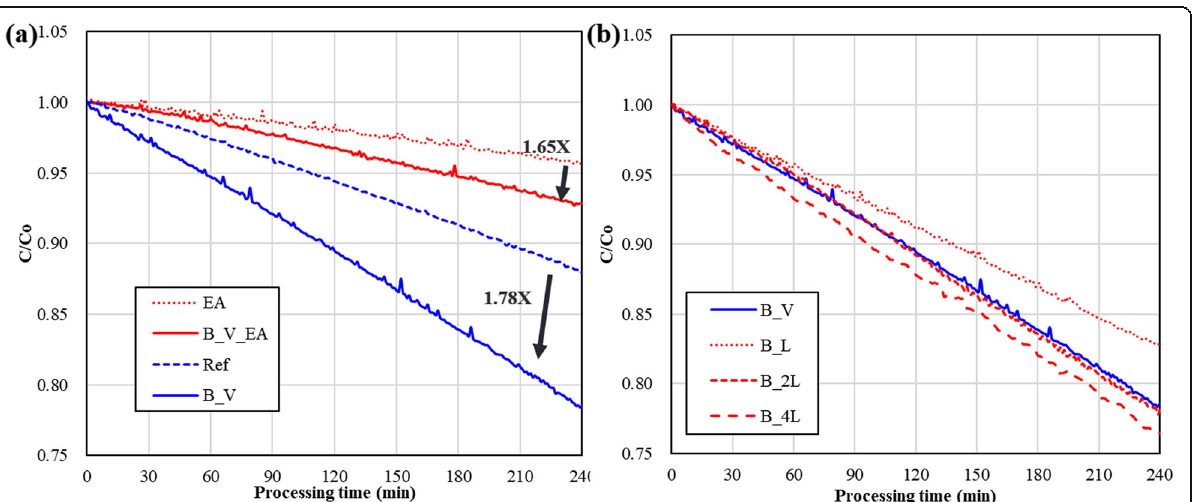
Fig. 3 Photocatalytic degradation of MO under the application of ( a ) a vertical magnetic field with and without EA and ( b ) various magnetic